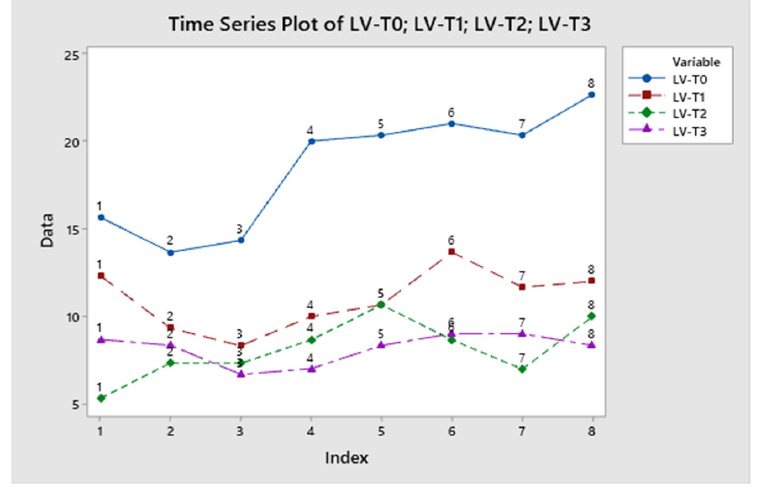
Figure 4. Principal component analysis (PCA) of the different stages of P. ziziphi according to the different treatment rates ( A ); double projection diagram for the two components ( B ). Means in the same column with different superscripts are significantly different ( p < 0.05).